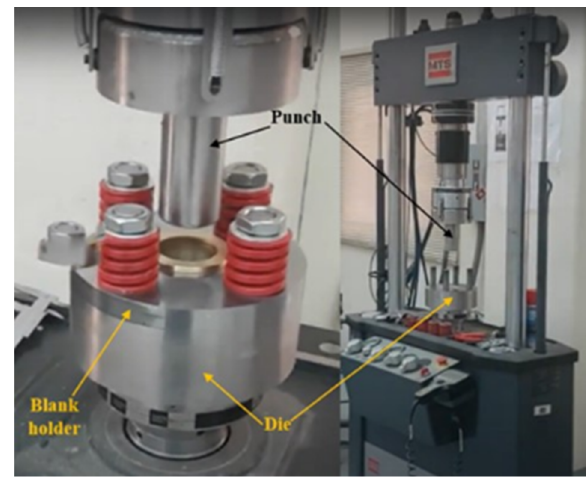
Figure 14. The experimental work setup for the deep drawing process.